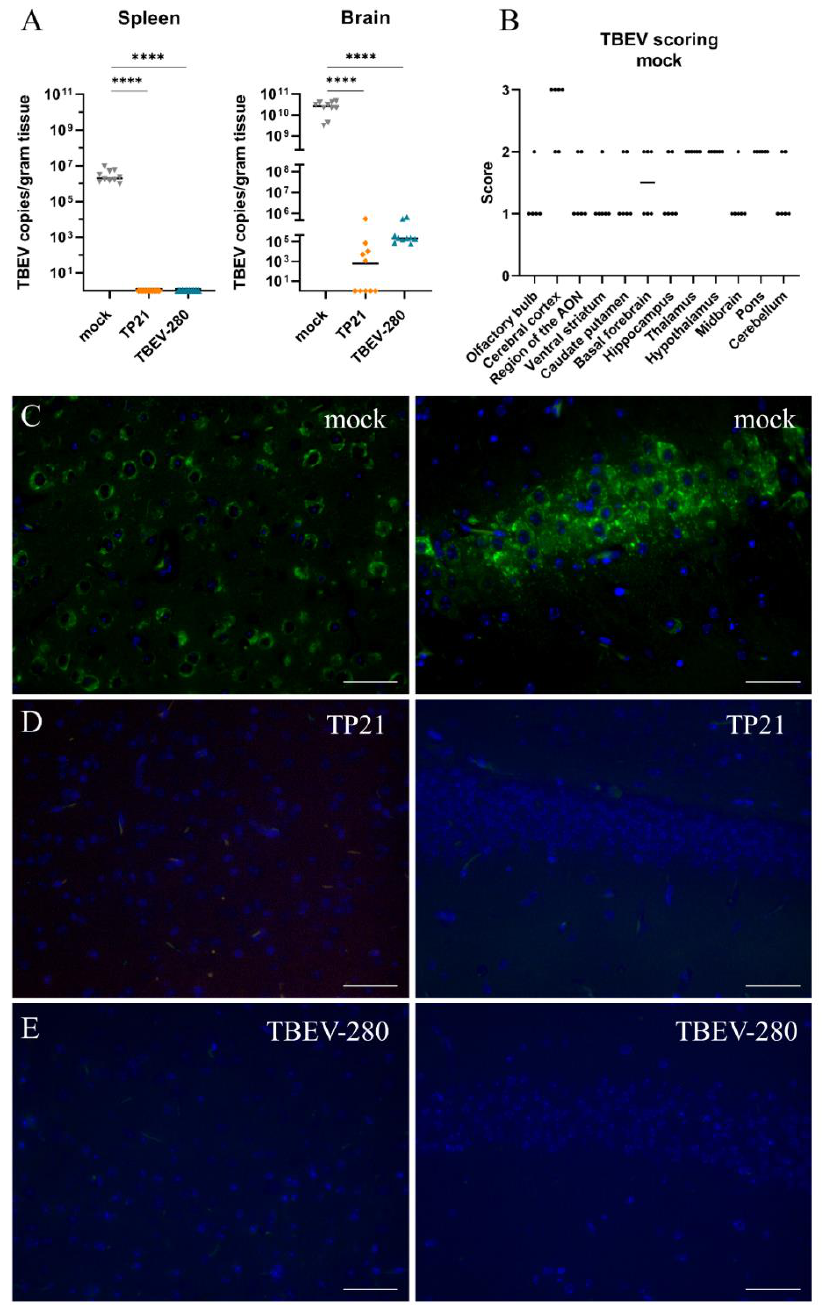
Figure 2. TBEV distribution in the periphery and in the CNS. ( A ) qPCR analysis of viral RNA isolated from the spleen and brain of mock ( ▼ ), TP21 ( ) and TBEV-280 ( ▲ ) immunized mice. RNA copies per gram tissue were determined and data obtained from individual mice were plotted, bars indicate median ( n = 10; **** p < 0.0001) ( B ). Tissue sections were stained with antibody targeting TBEV E-protein (green) and Hoechst (nuclei, blue) and virus antigen distribution in brain of mock immunized mice was scored based on the frequency of infected cells in the high power fields (HPF) analyzed ( n = 6). Representative immunofluorescence images from cerebral cortex (left panels) and hippocampus (right panels) regions from mock immunized ( C ), TP21 immunized ( D ), and TBEV-280 immunized ( E ) mice infected with TBEV-Hypr are depicted here. Scale bars 50 µ